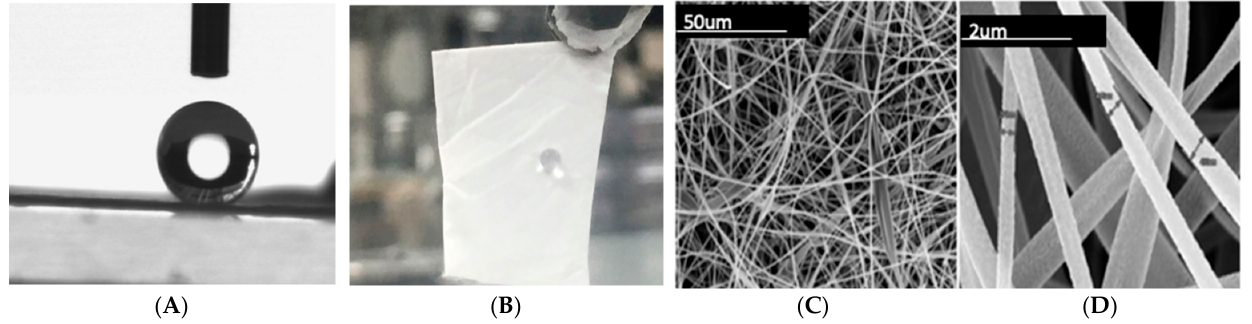
fl ow rate of 30 µL/min and a working distance of 7 cm. These conditions will reproduce the morphology of the membrane/mats illustrated in Figure 3 from reference [15]. A pro- cess map is available for electrospun CA [4], a guide on modifying the structure of these Figure 2. ( A ) The cell density on the glass coverslip, or within the scaffold; * cell density differs from fi lters as needed. on glass [11]; ( B ) left: the natural scaffold (ECM); right: synthetic scaffold [4].